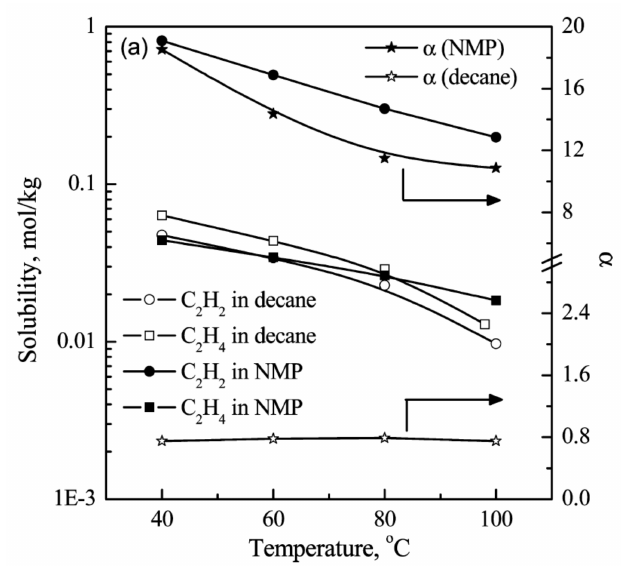
Figure 12. Solubility of acetylene and ethylene in NMP and decane. The catalyst is Pd/low surface area silica gel (reproduced with permission from [265]. Copyright 2013, American Chemical Society.).